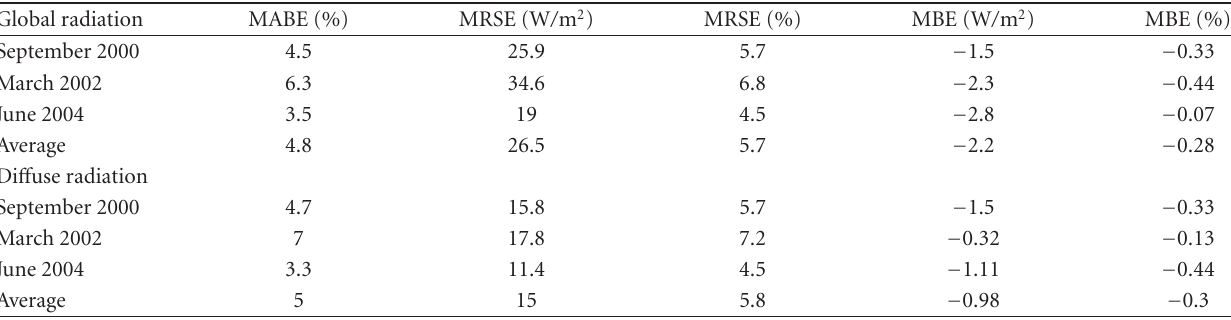
Table 1: Evaluation statistics for GRNN.